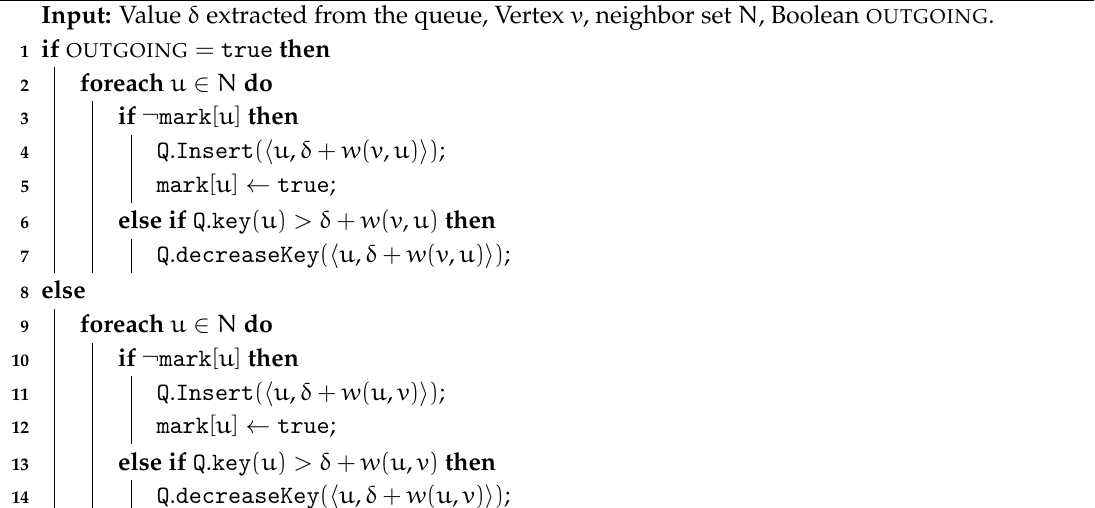
Algorithm 7: Sub-Procedure RELAX used in Procedures FCLEAN and